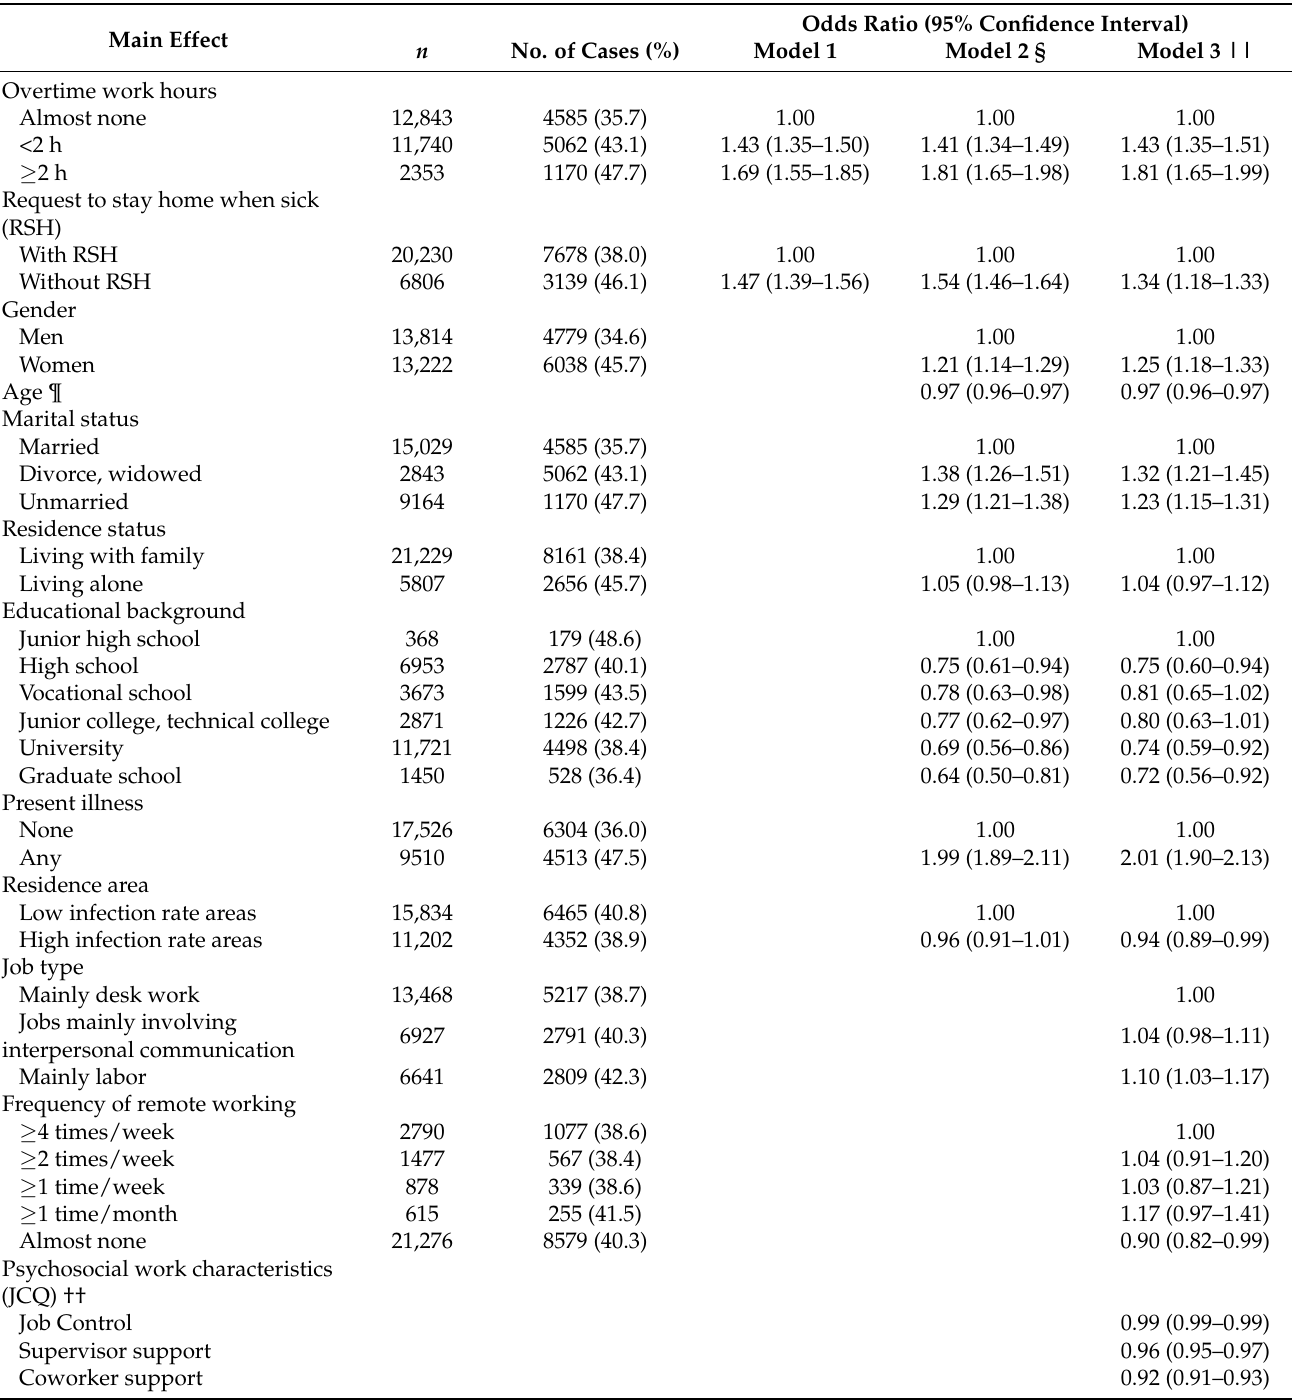
Table 2. Main effects of overtime work hours, RSH †, and other covariates on psychological distress ‡: multiple logistic regression